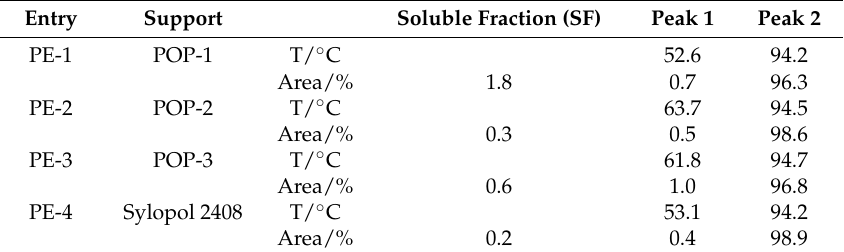
Table 3. Temperature rising elution fractionation (TREF) analysis results.